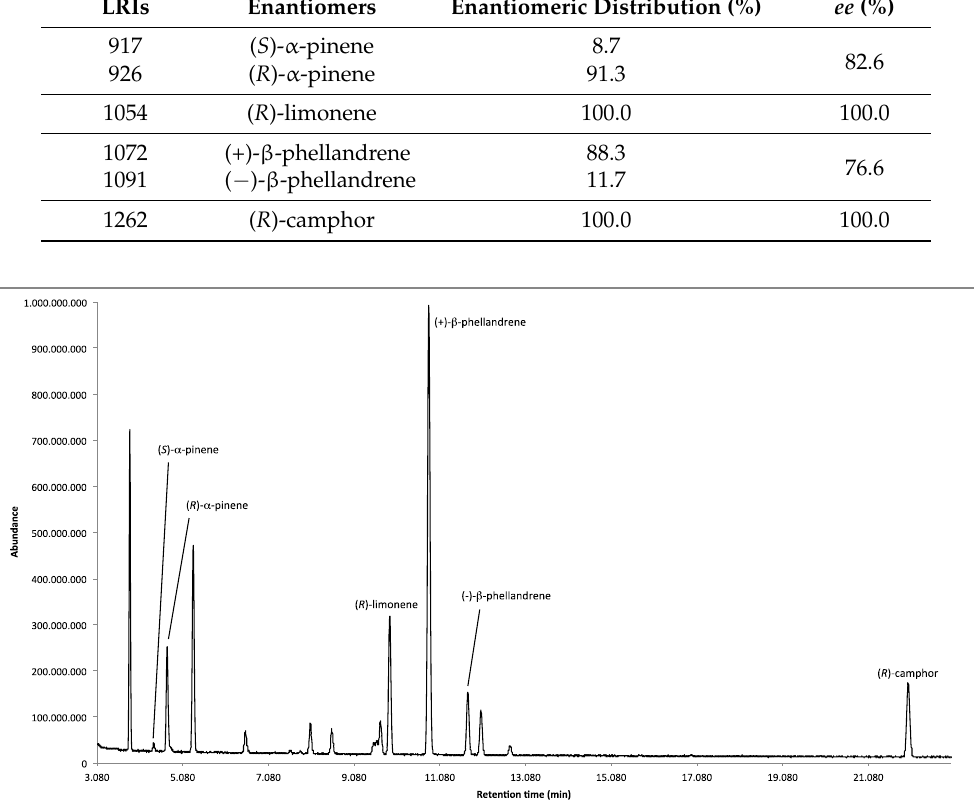
Table 2. Enantioselective analysis of L. heteromorpha EO on diacethyl terbutylsilyl- β -cyclodextrin column.